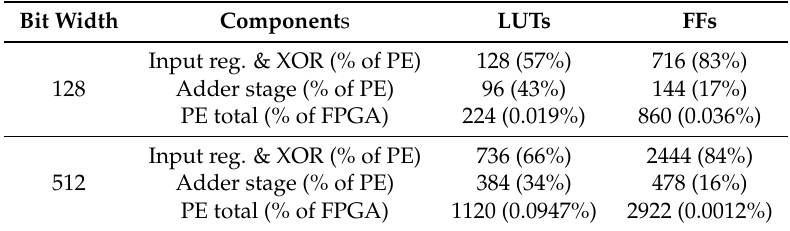
Table 5. Resource utilization of single Hamming distance processing elements.